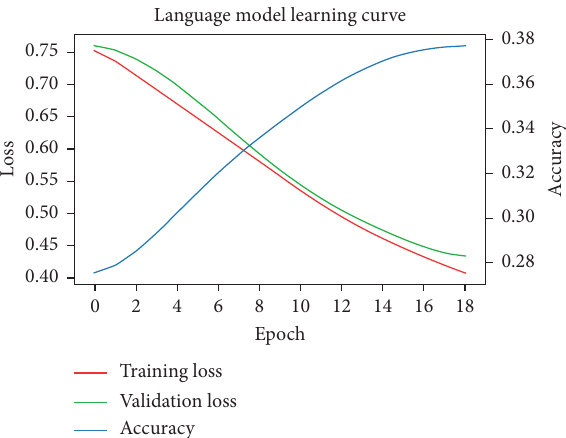
Figure 4: Language model learning curve. Accuracy here is defined as the percentage of predicted correct next word from a given vocabulary. Initially, the language model AWD-LSTM can achieve an accuracy of only 0.28; after 15 epochs, the accuracy improved to 0.38, a significant